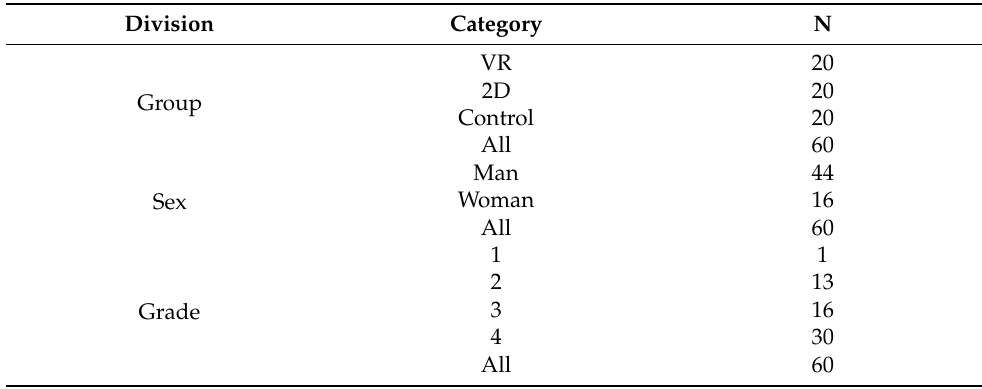
Table 2. Demographic